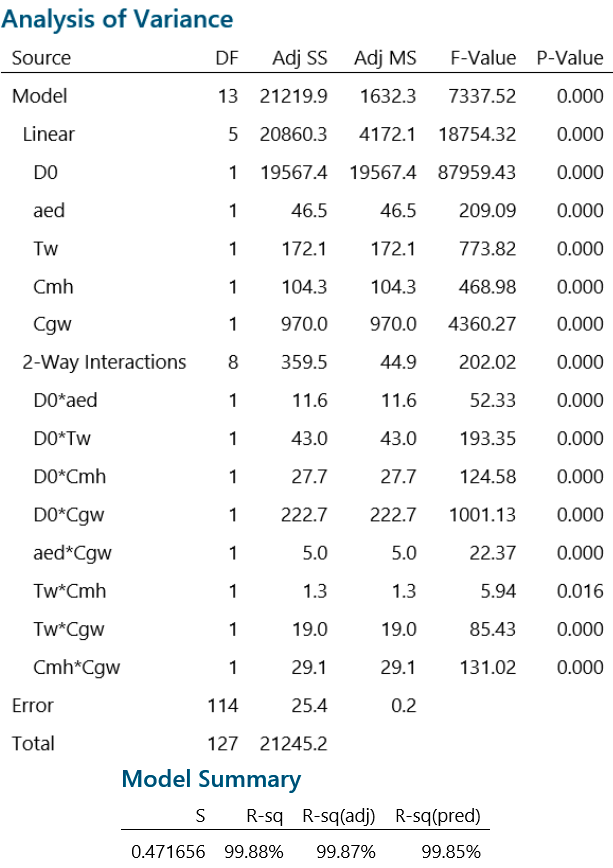
Figure 7. Estimated effects and coefficients for D e,op.